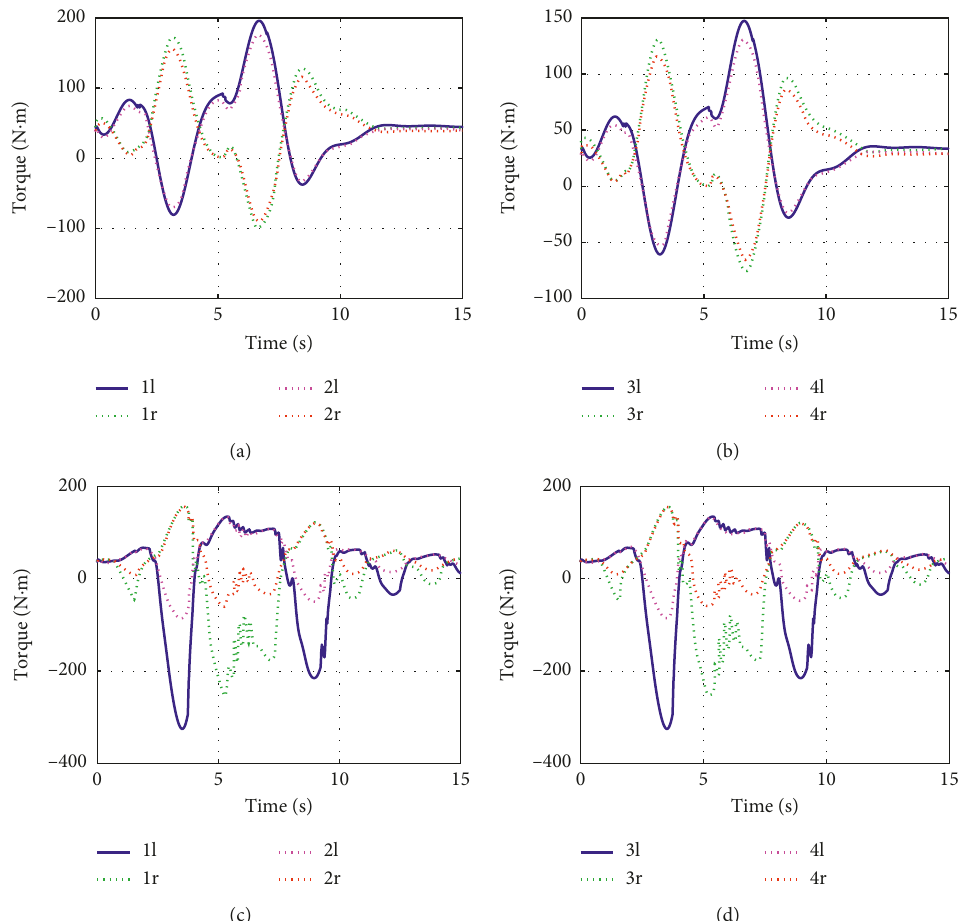
Figure 18: HIL simulation results: (a) ESC torque distribution of front four wheels; (b) ESC torque distribution of rear four wheels; (c) DYC torque distribution of front four wheels; (d) DYC torque distribution of rear four